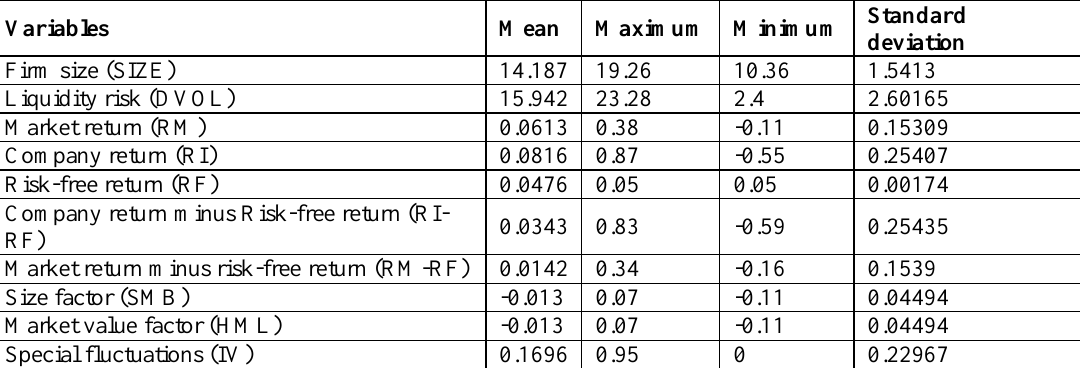
Table 1: Descriptive statistics of model